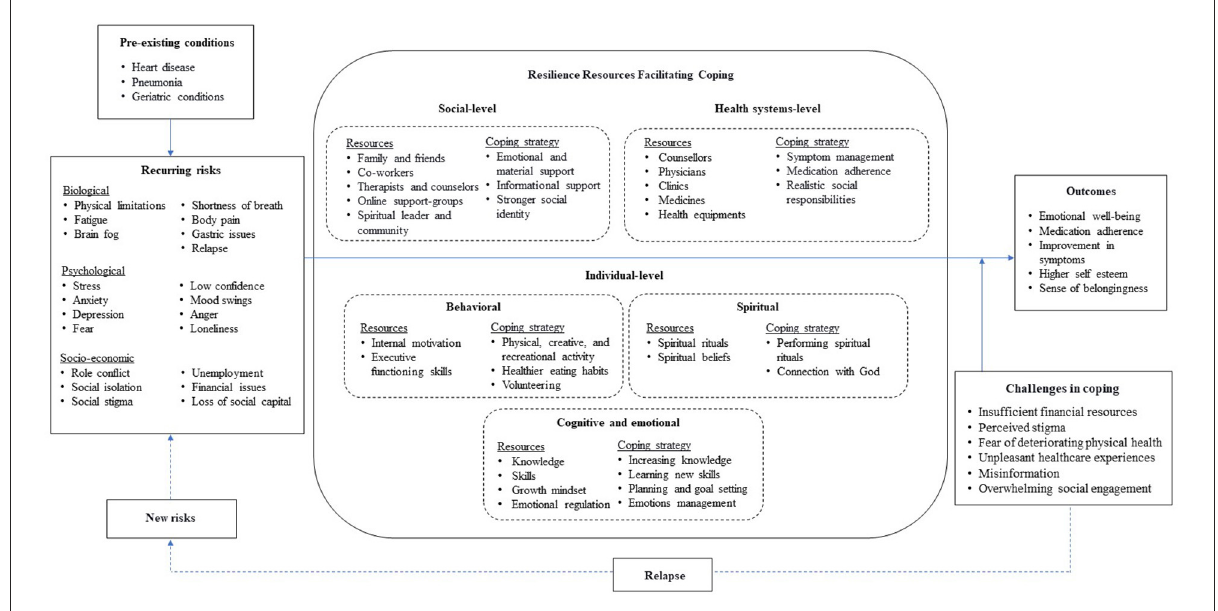
FIGURE1 The conceptual framework of resilience resources among female-long-haulers.